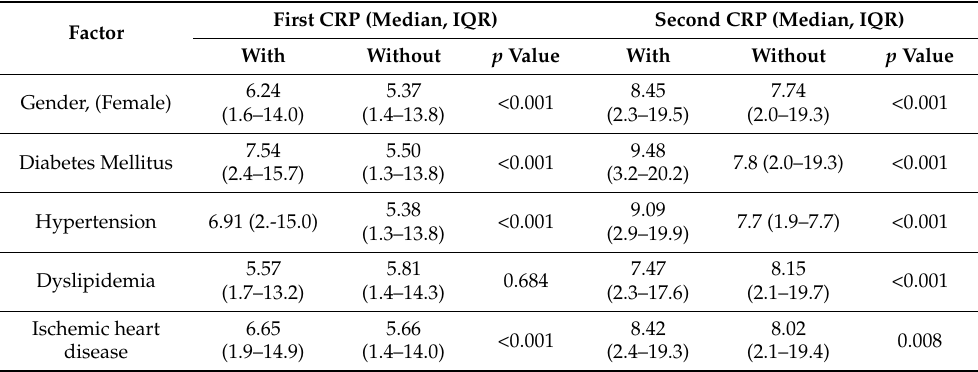
Table 2. The subgroup analysis of the first and second CRP measurements. First CRP (Median, IQR) Second CRP (Median, IQR) Factor With Without Gender,